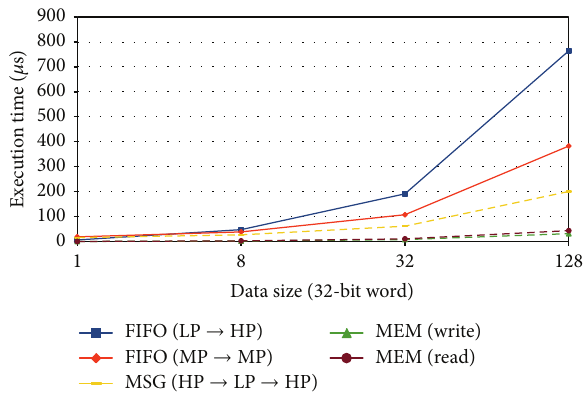
Figure 22: SW-SW communication times for different sizes of